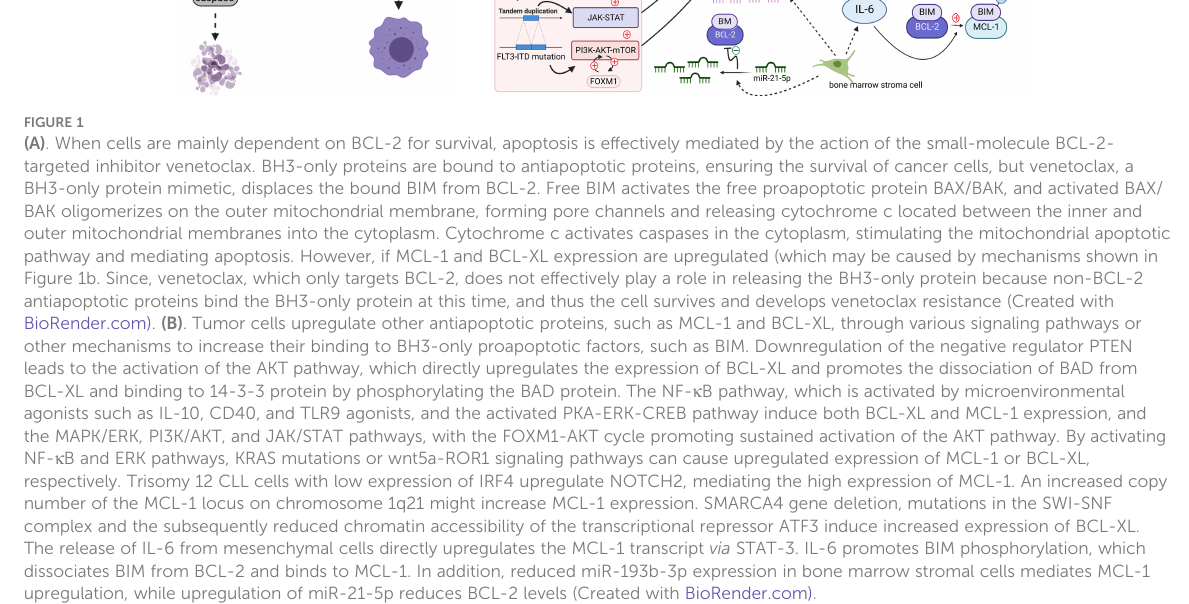
BioRender.com). (B) . Tumor cells upregulate other antiapoptotic proteins, such as MCL-1 and BCL-XL, through various signaling pathways or other mechanisms to increase their binding to BH3-only proapoptotic factors, such as BIM. Downregulation of the negative regulator